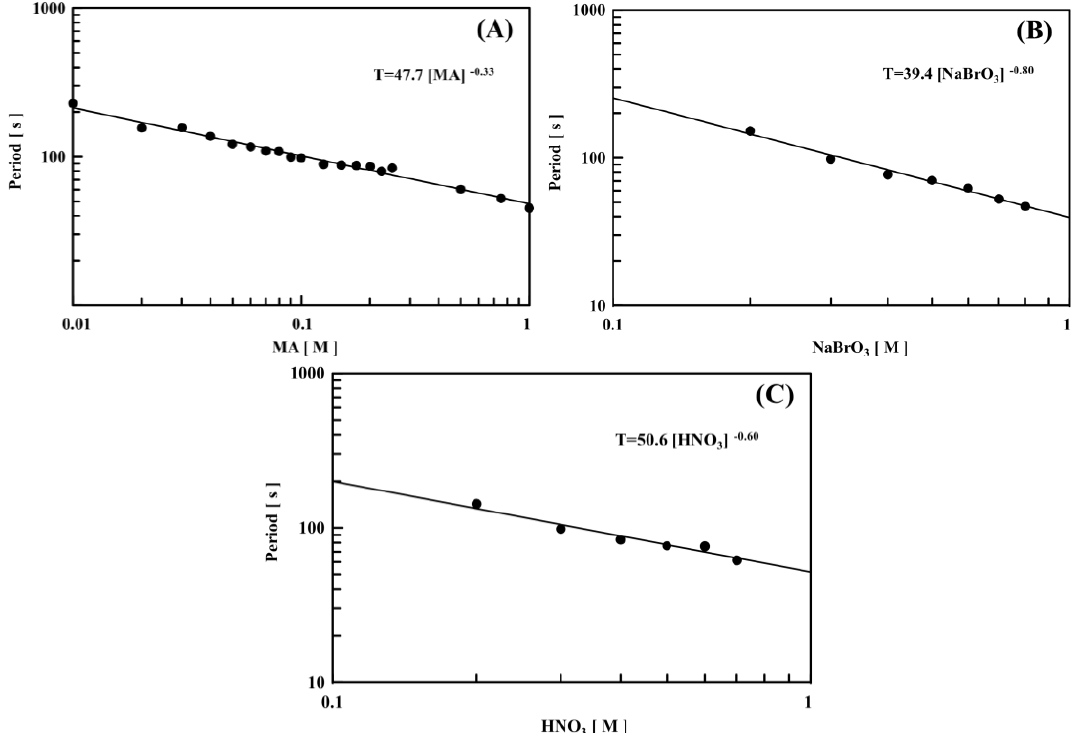
Figure 7. Logarithmic plots of period T (s) of 0.5 wt% poly(NIPAAm- co -Ru(bpy) solution vs. initial molar concentration of one BZ substrate at constant temperature ( T = 18 °C), with fixed concentrations of the other two BZ substrates: ( A ) [NaBrO